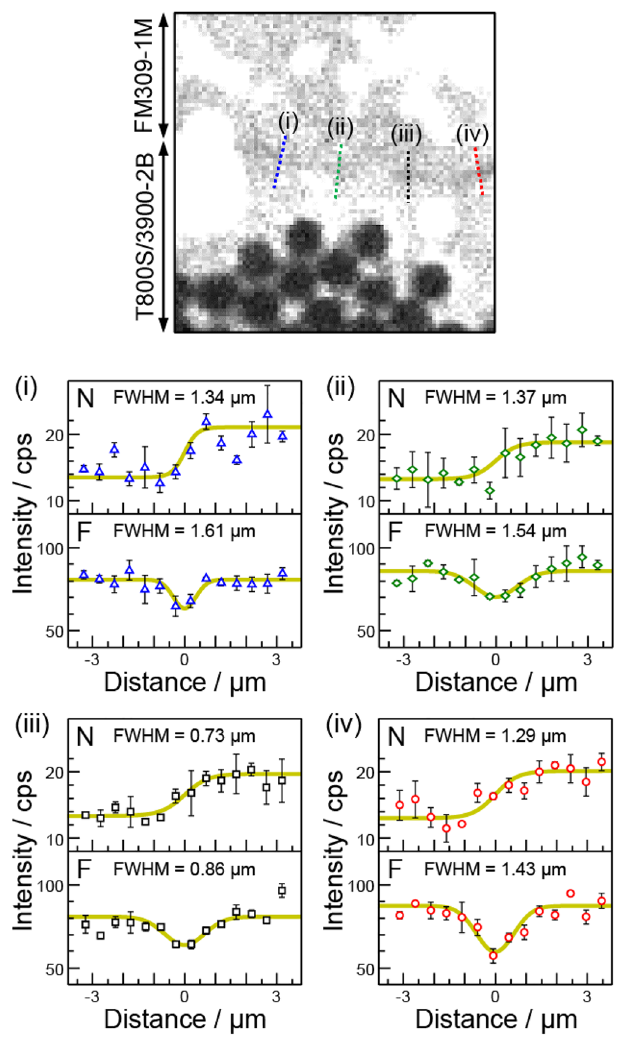
Figure 5. Fitting analysis of the intensity profile in the soft X-ray images. The F Kα image at the CF-matrix/ adhesive interface region and the fitting analysis of the N and F Kα intensity profiles at the positions of (i), (ii), (iii), and (iv). The N and F Kα intensity profiles were analyzed using Boltzmann and Gaussian functions, respectively. The best fit results are indicated by the thick solid curve. The FWHM of the best fit curve is provided in each figure. The triangle (i), diamond (ii), square (iii), and circle (iv) data points correspond to the symbols used in Fig.